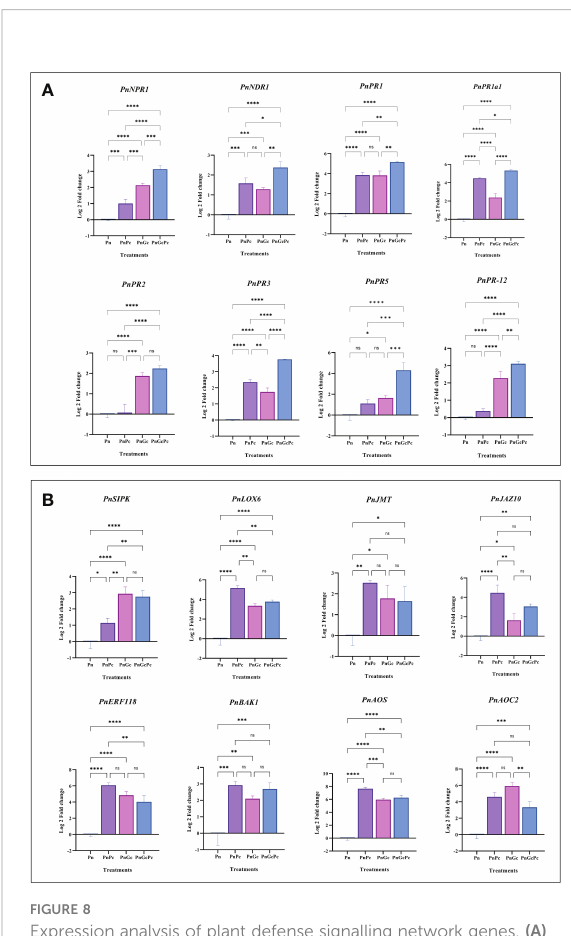
FIGURE 8 Expression analysis of plant defense signalling network genes. (A) Major Pathogenesis-related (PR) genes ( PnNPR1 : Non expressor of pathogenesis-related genes 1, PnNDR1 : Non-Race Speci fi c Disease Resistance-1, PnPR1 : Pathogenesis-related 1, PnPR1a1 : Pathogenesis related-1 Isoform A1, PnPR2 : b -1,3-Glucanase, PnPR3 : Chitinase, PR5 : Thaumatin like , PnPR12 : Defensin, and (B) Hormone signalling genes: PnSIPK: Putative Salicylic-induced MAPK, PnLOX6- Lipoxygenase 6 , PnJMT -Jasmonate-O- Methyltransferase , PnJAZ10 -Jasmonate zim domain protein 10 , PnAOC2 -Allene oxide cyclase 2 , PnAOS- Cytochrome P450 allene oxide synthase , PnERF118 -Ethylene-responsive transcription factor ERF118 , PnBAK1 -Brassinosteroid insensitive 1-associated receptor kinase1-like) in P. nigrum detached leaves